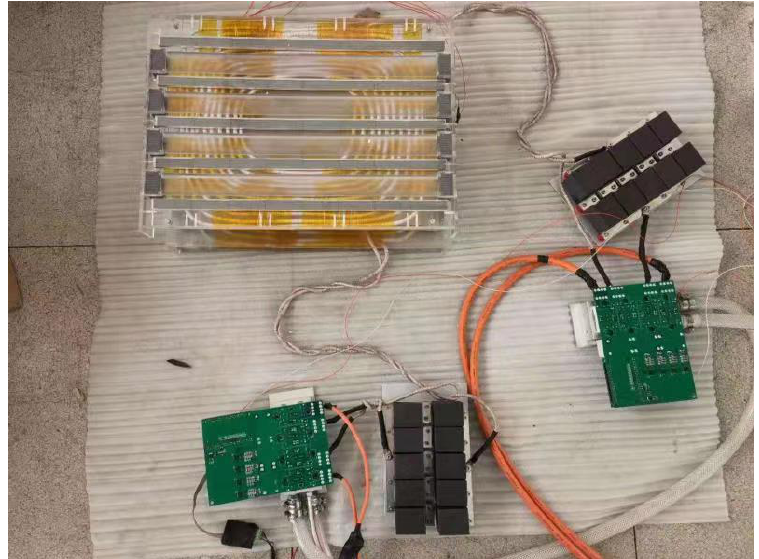
Figure 14. WPT system